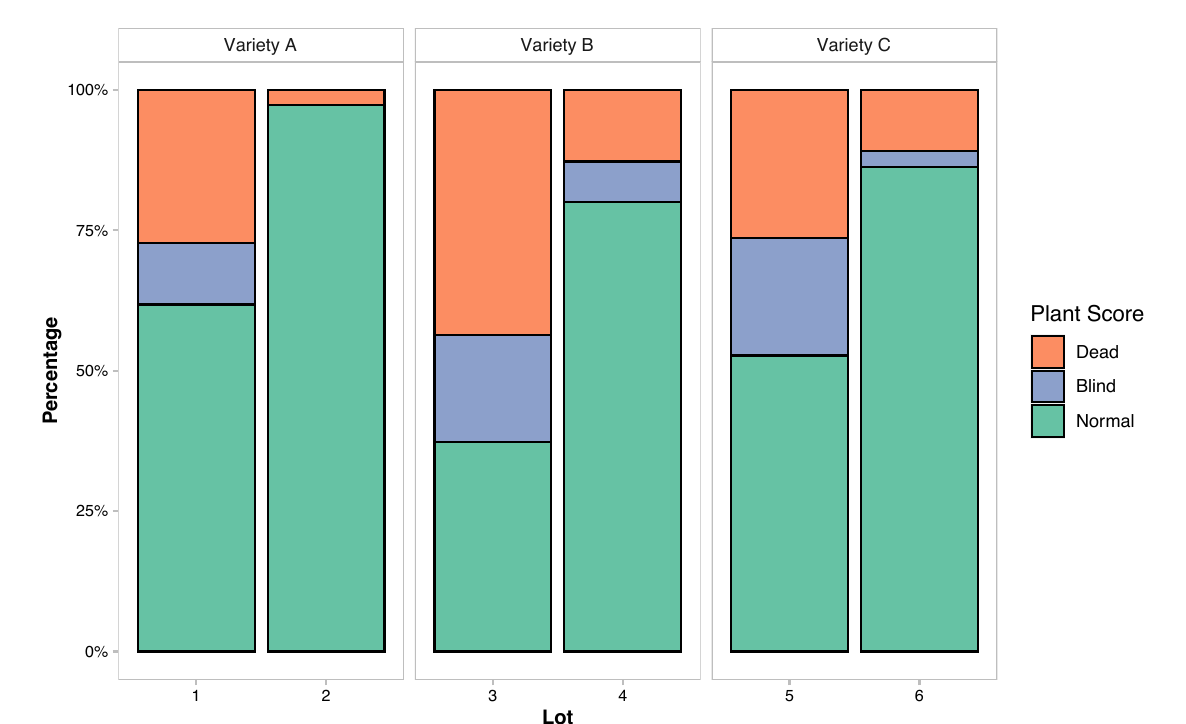
Figure 10. Plant evaluation for induced seeds and scores for dead, blind and normal seedlings after 2.5–5 weeks of growth in the greenhouse following 48 h at 1.5 ◦ C and 72 h at 15 ◦ C for Q2 measurements. Plants were scored per the descriptions in Table